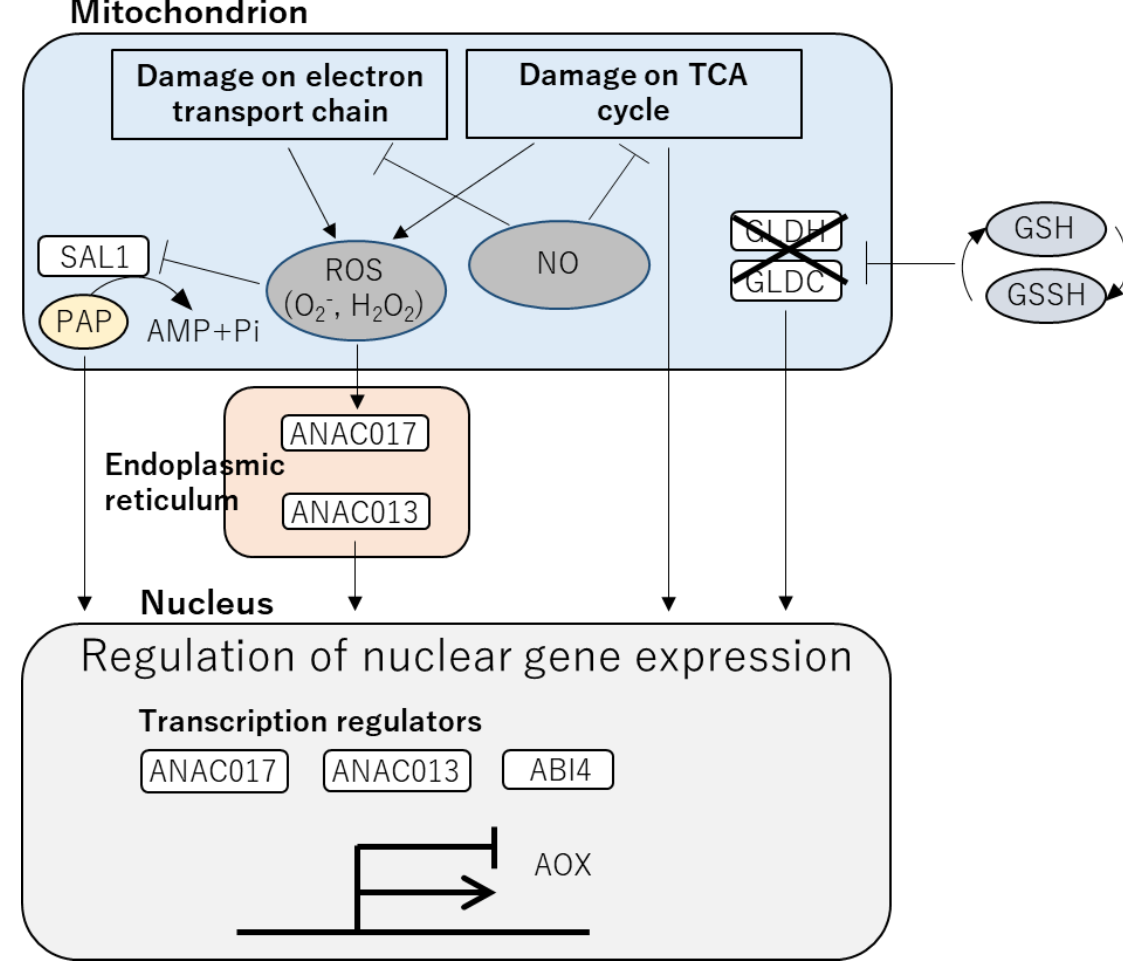
Figure 2. Retrograde signaling from the mitochondria that might be associated with heat response in plants. Damages on the electron transport chain or TCA cycle generate ROS. ROS can activate ANAC transcription factors that enhance expression of the transcript encoding AOX. In contrast, ABI4 activated by mitochondrial retrograde signaling inhibits AOX. Similar to the chloroplast, ROS can inhibit SAL1. Inhibition of mitochondrial enzymes (GLDH and GLDC) by S-glutathionylation might activate retrograde signaling. NO can also inhibit enzymes involved in the electron transport chain and TCA cycle via S-nitrosylation, leading to activation of retrograde signaling.